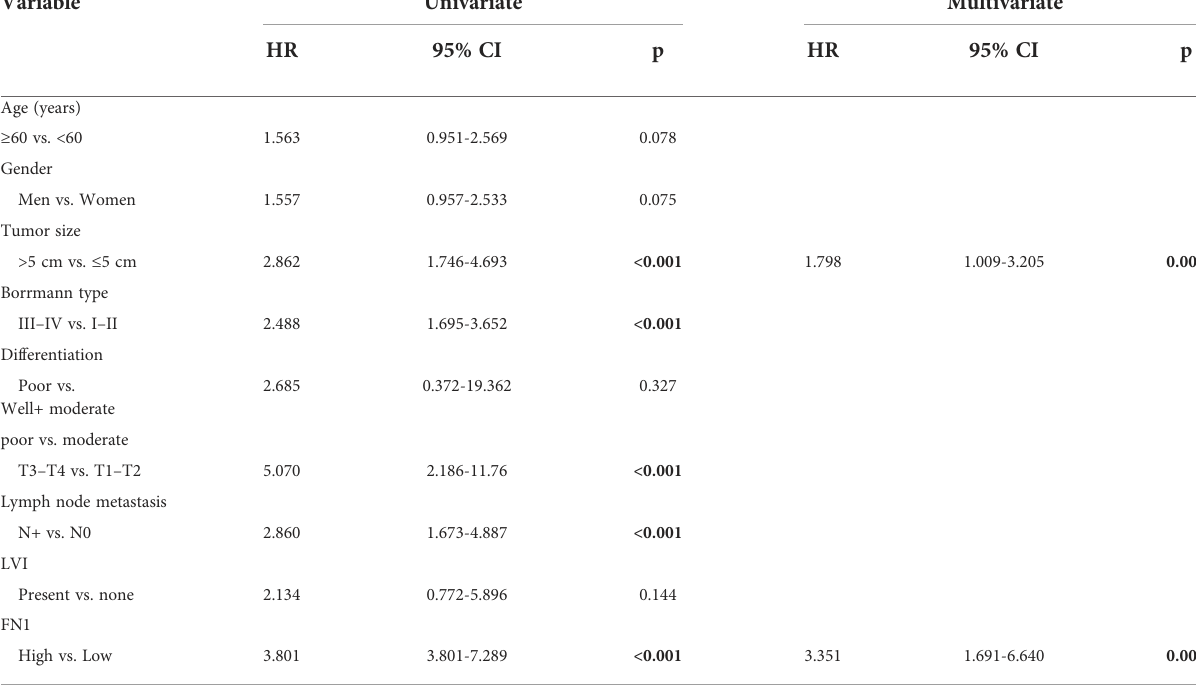
TABLE 2 Univariate and multivariate Cox risk regression analyses of overall survival in patients with gastric cancer.